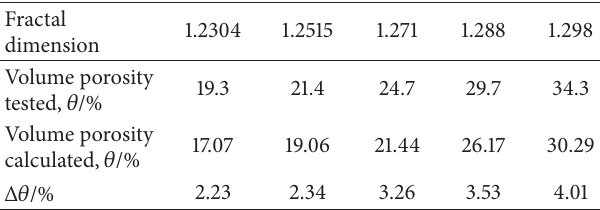
Table 1: Volume porosity of porous metal materials made by irregular powder with the particle size of 44 ∼ 74 𝜇 m.